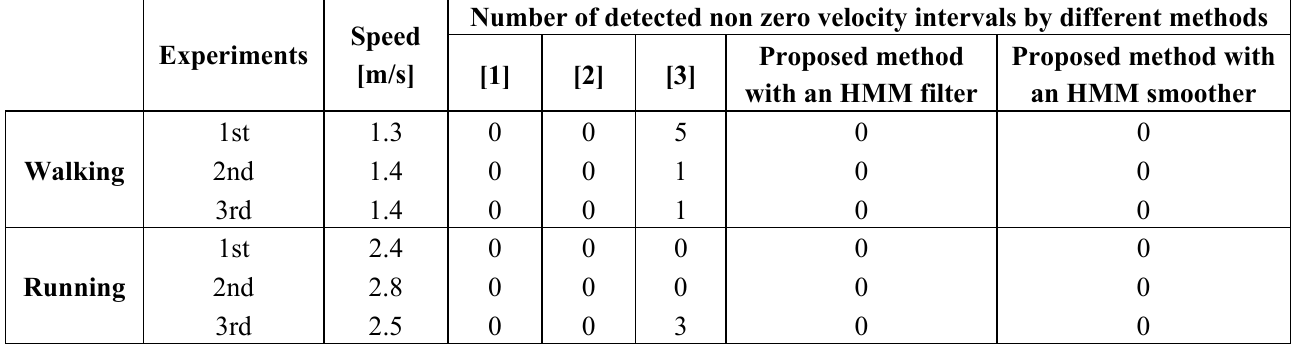
Table 3 . Number of falsely detected zero velocity intervals by different